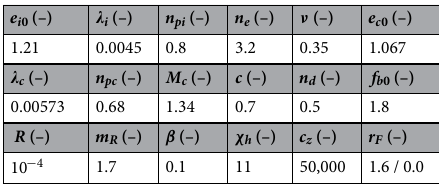
Table 4. Material parameters of ISA model for KFS from 41 .